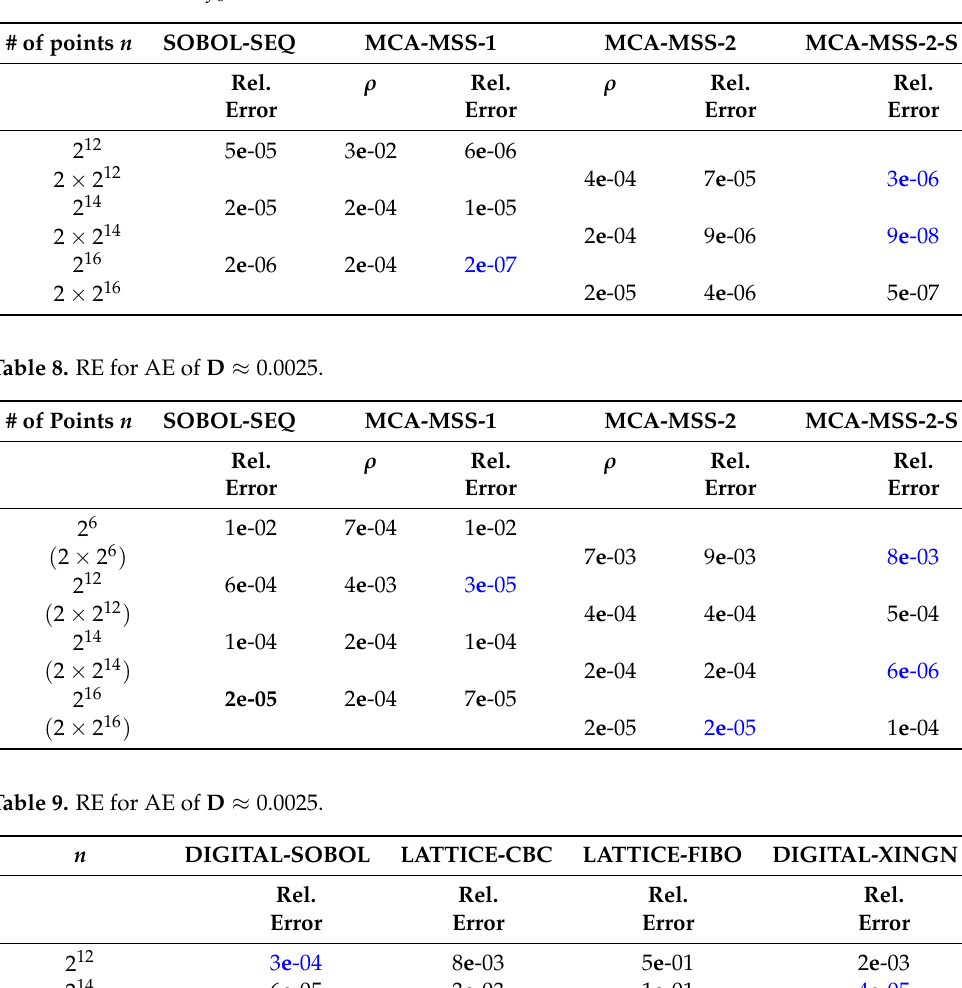
Table 7. RE for AE of f 0 ≈ 0.27.